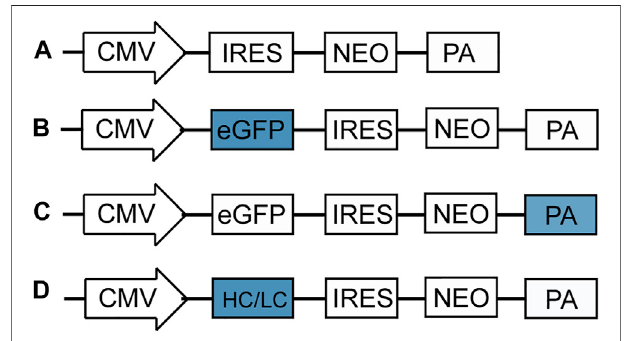
FIGURE 1 | Schematic representation of vectors used in this study. (A) pIRES-neo expression vector that contains CMV promoter, internal ribosome entry site (IRES), neomycin (neo) and BGH poly A; (B) eGFP gene was cloned downstreamCMVpromoterofpIRES-neovectortoproduce thepIRES- EGFP vector; (C) Four different poly A elements, including M BGH, Synt, HSV TKandSV40polyAreplacedtheBGHpolyAofpIRES-EGFPvectorbyfusion cloning technique to produce the vectors containing different poly A; (D) A dalimumab heavy chain (HC) and light chain (LC) gene replaced the eGFP of pIRES-GFP-poly A vector to produce the vectors containing